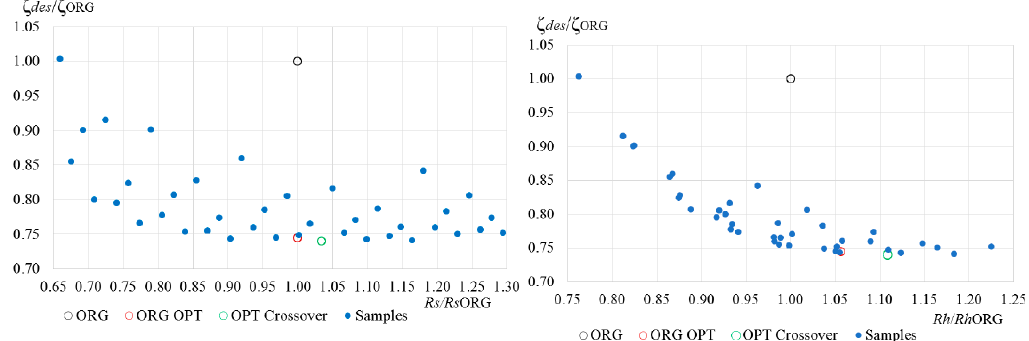
Figure 18. Influence of the curvature radii of the U-bend on the return channel loss coefficient.